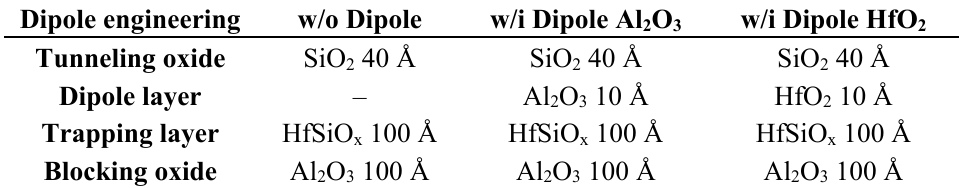
Figure 1. Cross-sectional cell structure of the TAHOS NVM device using dipole engineering. Table 1. Dipole engineering for TAHOS NVM